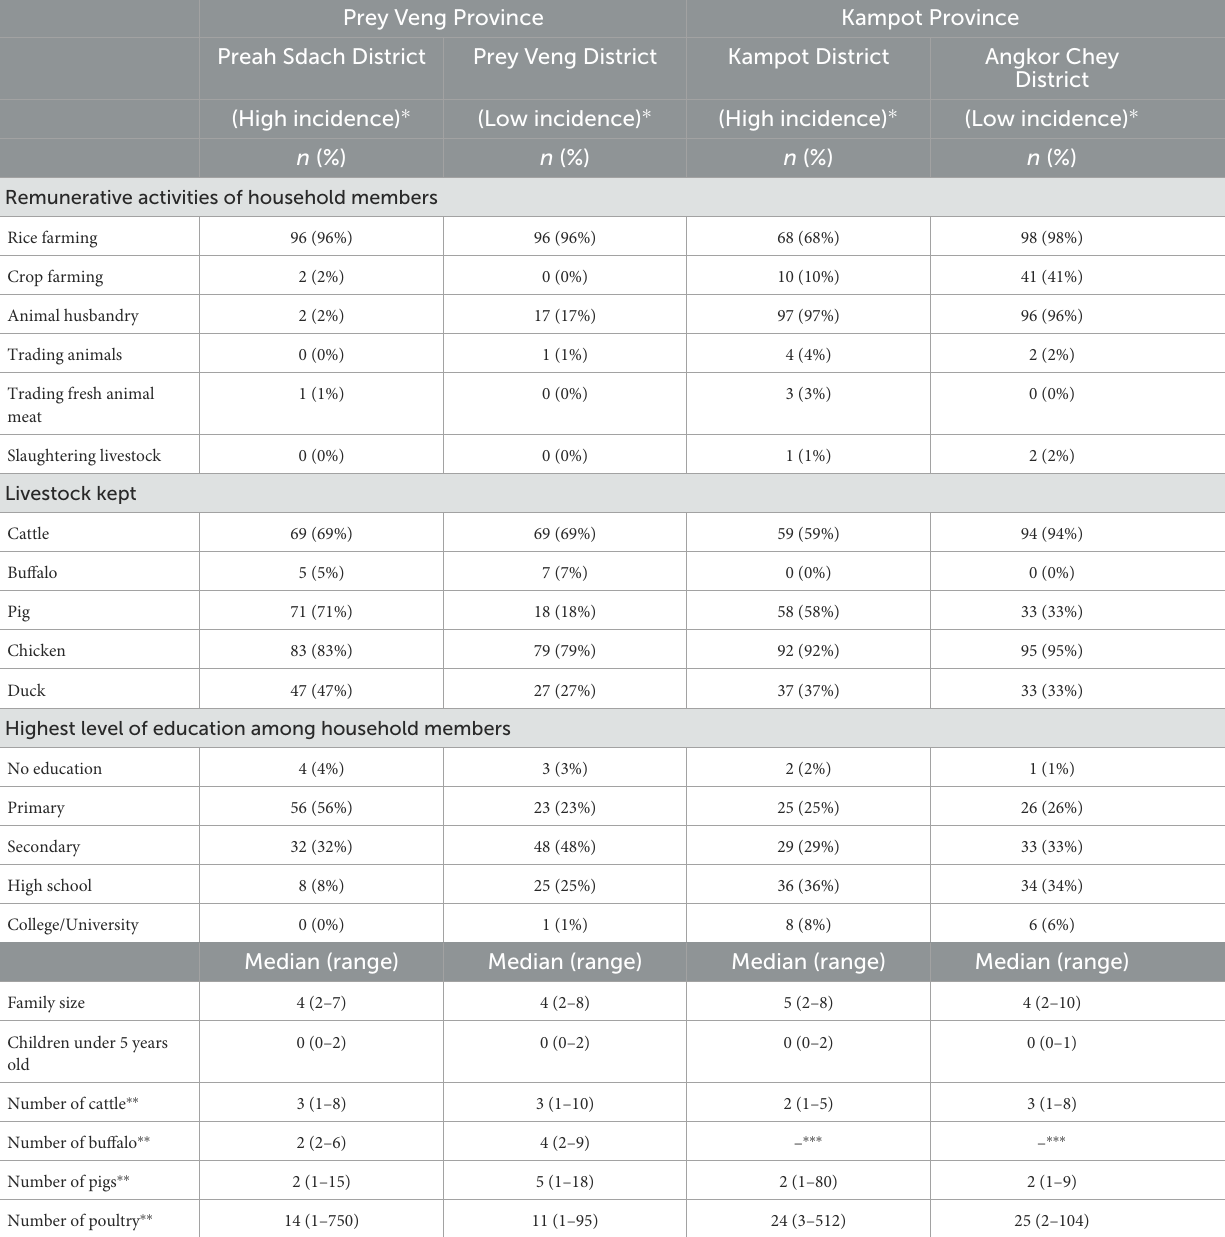
TABLE 1 Household characteristics ( N = 100 per